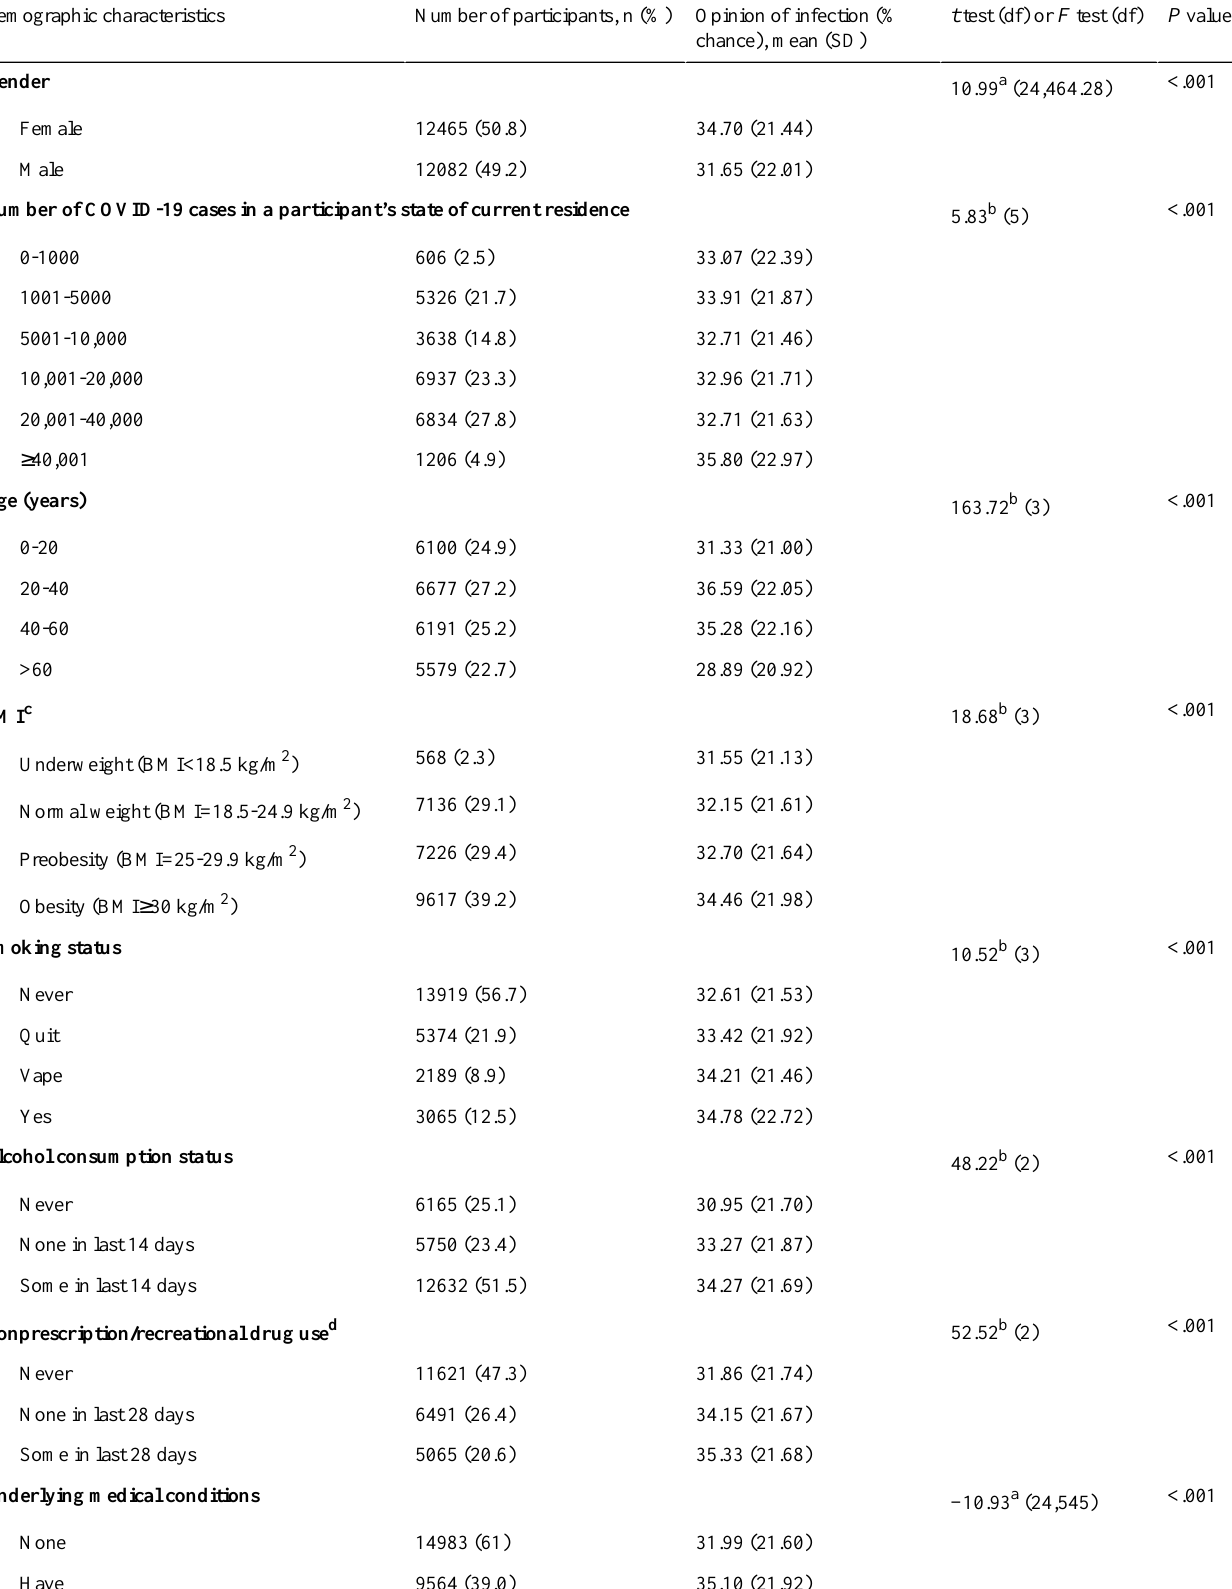
Table 2. Participants’ demographic characteristics and self-assessment results for their risk of contracting COVID-19, stratified by demographic variables